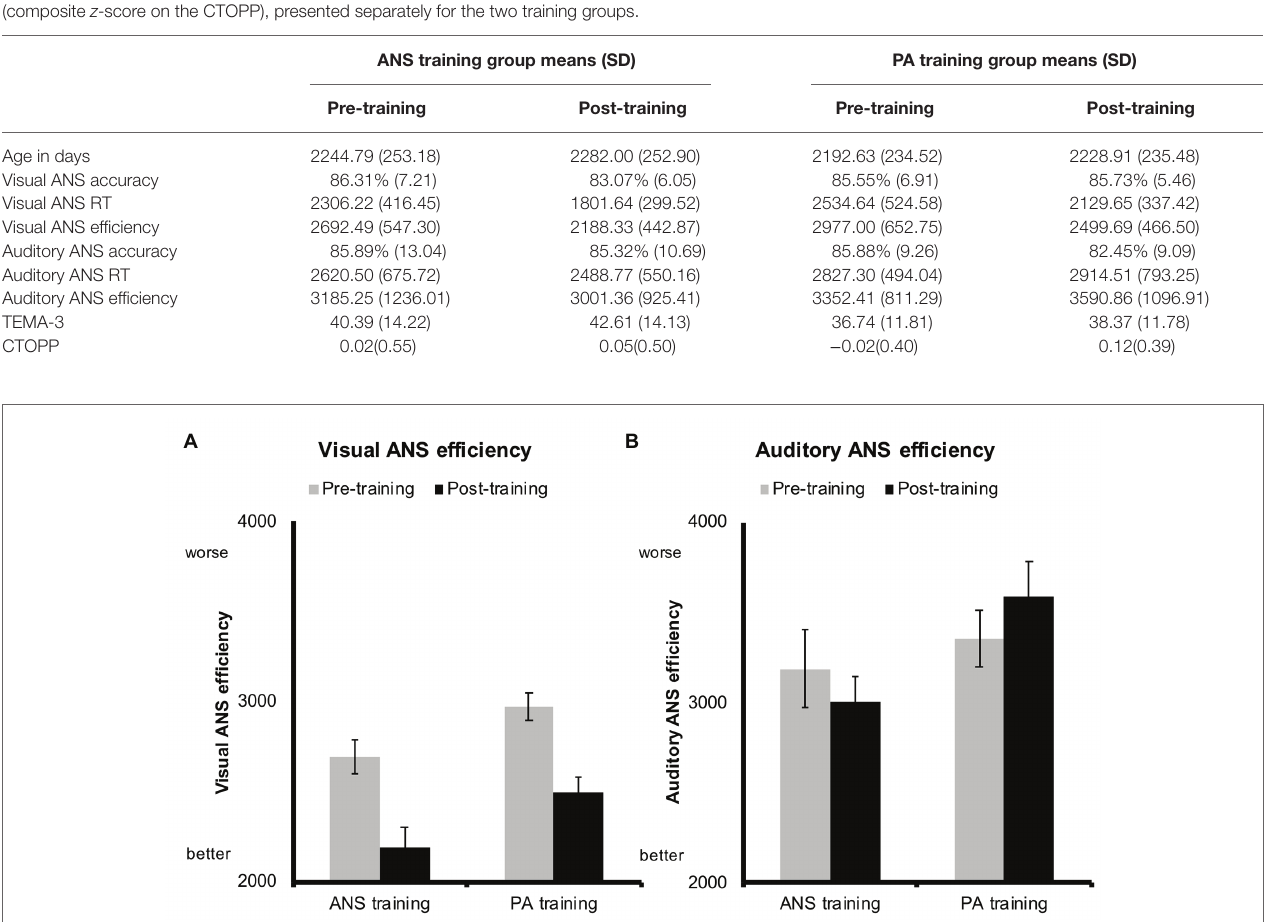
FIGURE 4 | (A) Visual and (B) auditory ANS efficiency before training (gray bars) and after training (black bars) for the ANS training group and the phonological awareness (PA) training group. Error bars depict standard errors. Efficiency is calculated as response time (RT)/accuracy, i.e., a larger value reflects worse ANS performance.